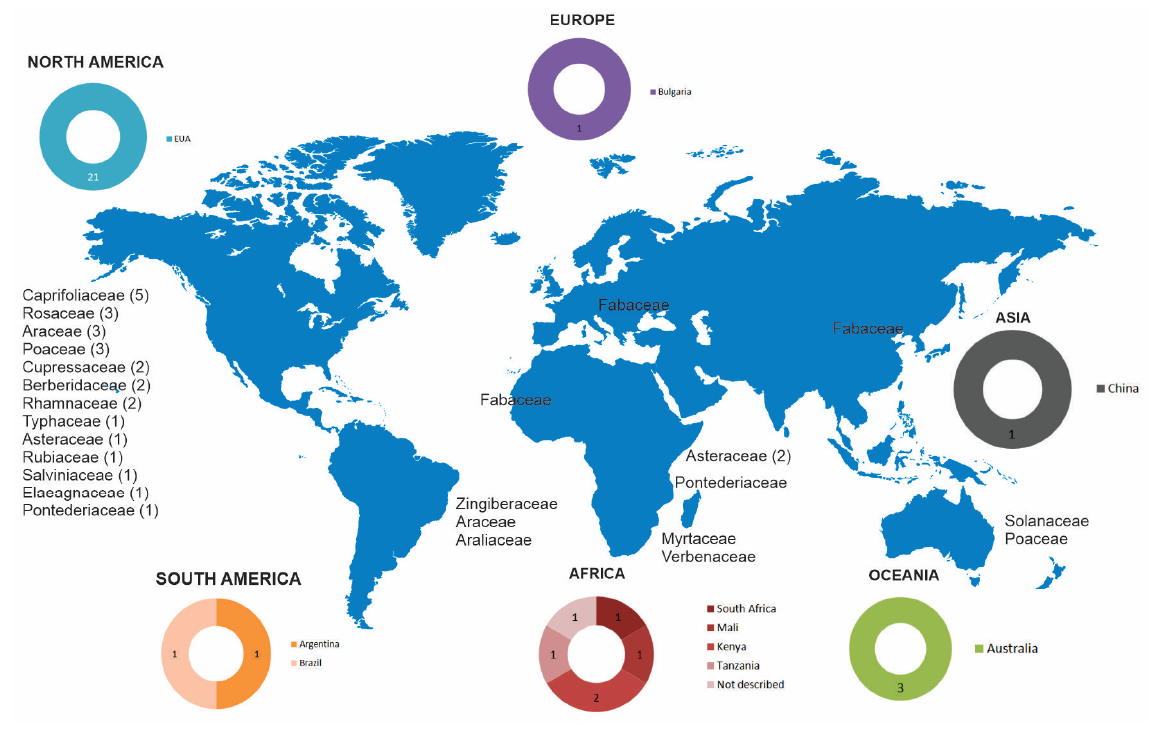
Figure 3. Geographical distribution for each article and invasive plant families, when cited.